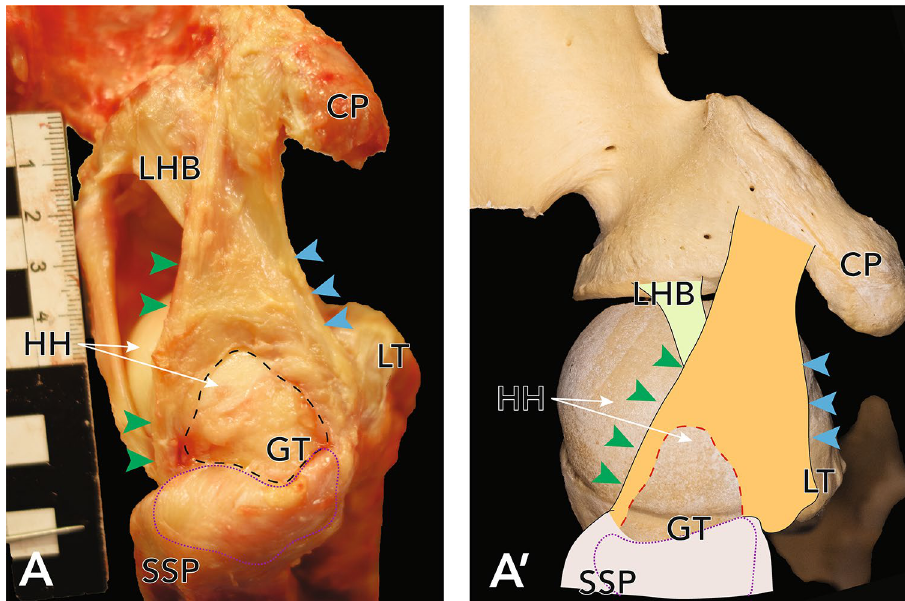
Figure 4. ( A ) Exemplary lesion to the posterolateral band of the CHL in a right shoulder, view from superior. ( A ′ ) Approximation of the photographs as an overlay on humerus and scapula. Dashed line delineates the size of the lesion, dotted line delineates the correlating partial tear of the SSP. HH humeral head, CP coracoid process, GT greater tubercle, LT lesser tubercle, SSP supraspinatus muscle, LHB long head of biceps brachii